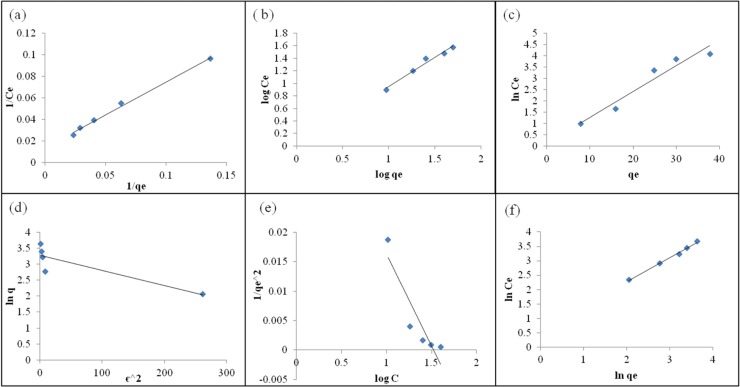
a) Langmuir isotherm b) Freundlich isotherm c) Tempkin isotherm d) D-R isotherm e) Harkin-Jura isotherm and f) Hasley isotherm for Cr(VI) biosorption by MSR4 strain (initial Cr(VI) concentration: 25–100 mg/L, biomass dosage: 2g/L, pH: 2.0, temperature: 27°C.